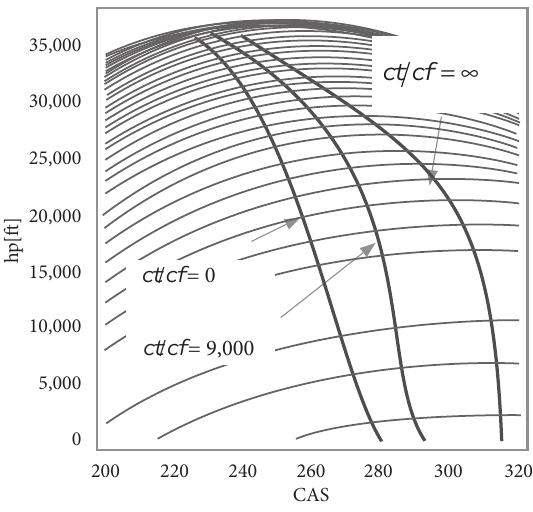
Fig. 1. The contours of constant RDOC and function of optimal CAS speed distribution for minimum RDOC , with h , for minimal direct operating costs, for B737300 with CFM56 engines, for ct cf = ∞ 0 9000,